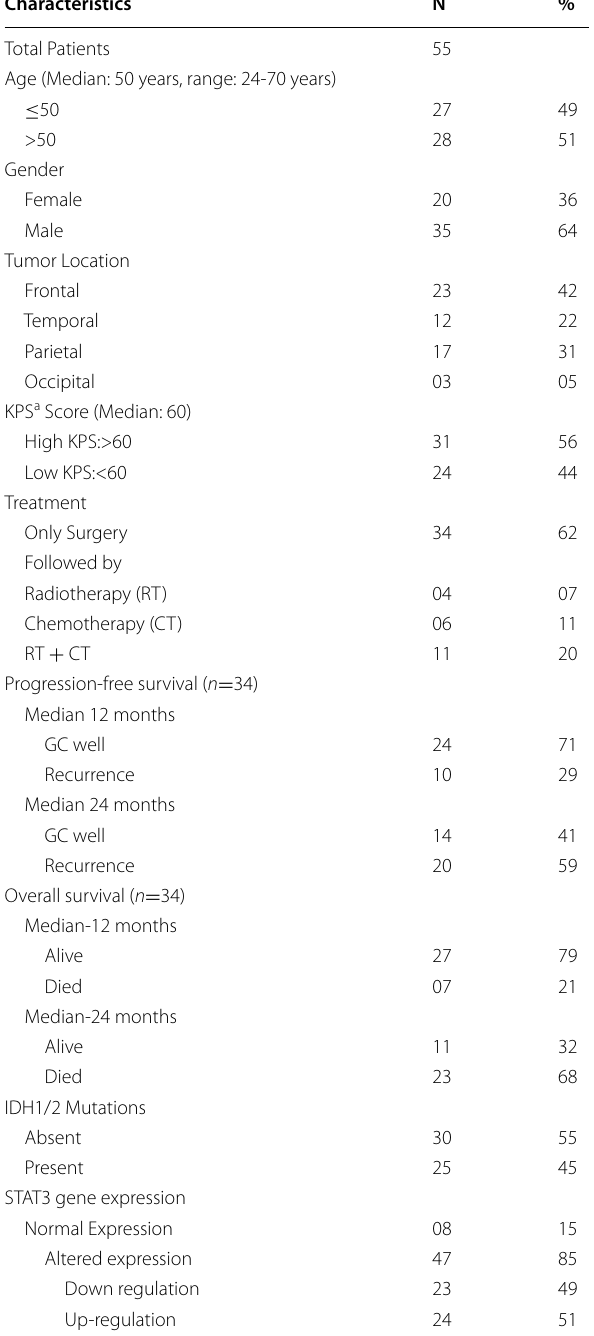
a Karnofsky Performance Status